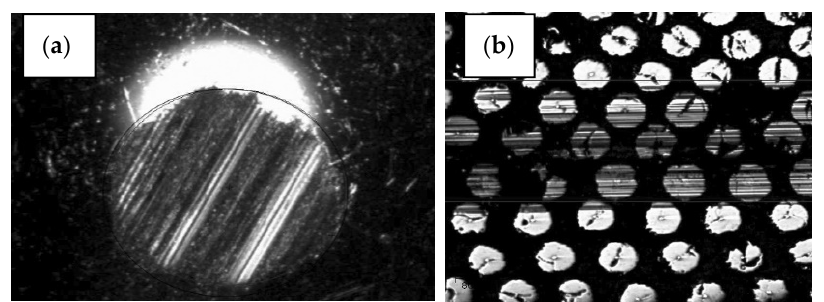
Figure 10. Wear images of the counterparty and the body under study ( a ) spherical counterpart made of steel 100 Cr 6; ( b ) the body being examined.